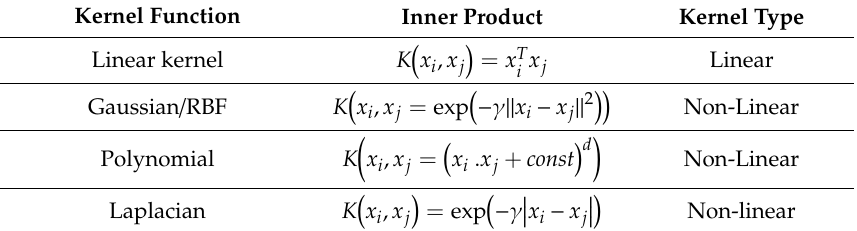
Table 3. Di ff erent kernel functions for learning of support vector machine